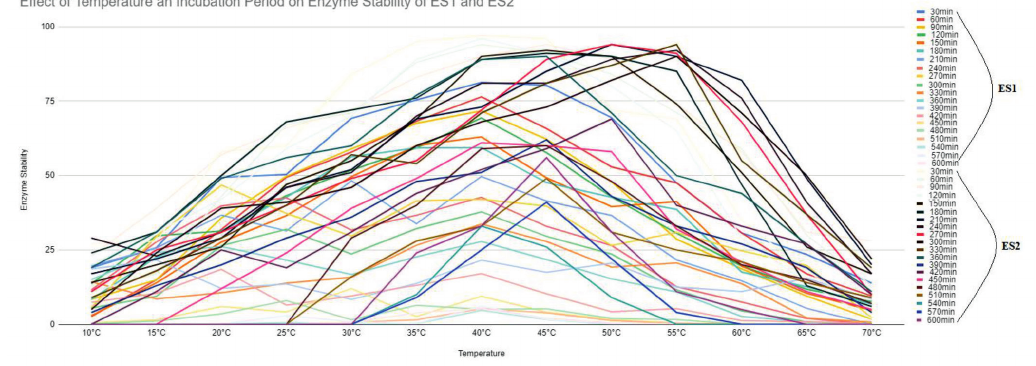
Fig. 3 . Effect of temperature and incubation period on enzyme stability of ES1 and ES2